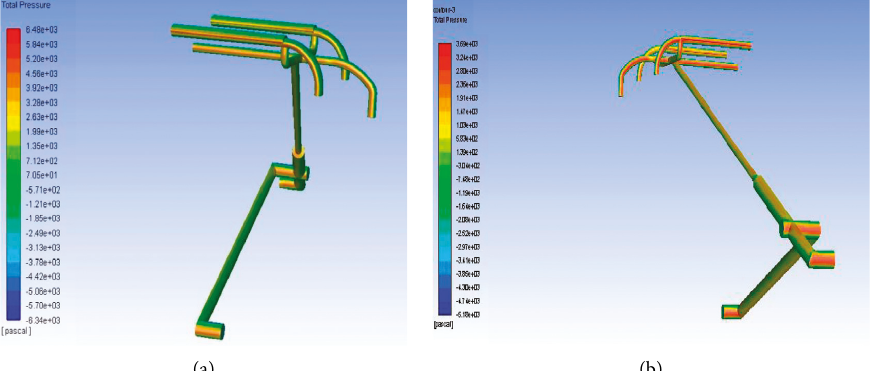
Figure 18: Total pressure map of the pantograph with elliptic edge cross-section at a train speed of 300km/h: (a) forward mode and (b) reverse mode.